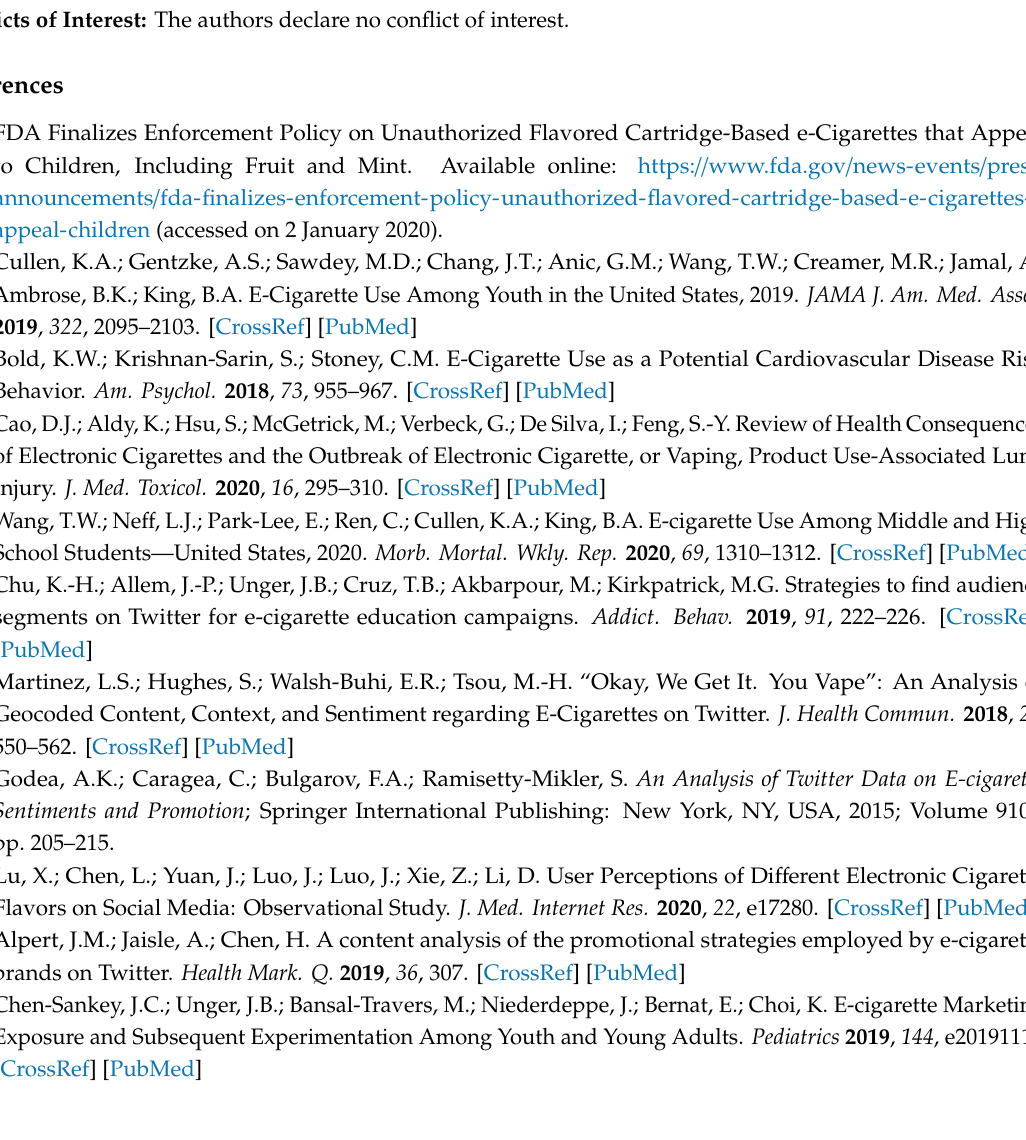
Table S1. Available disposable e-cigarettes collected from online